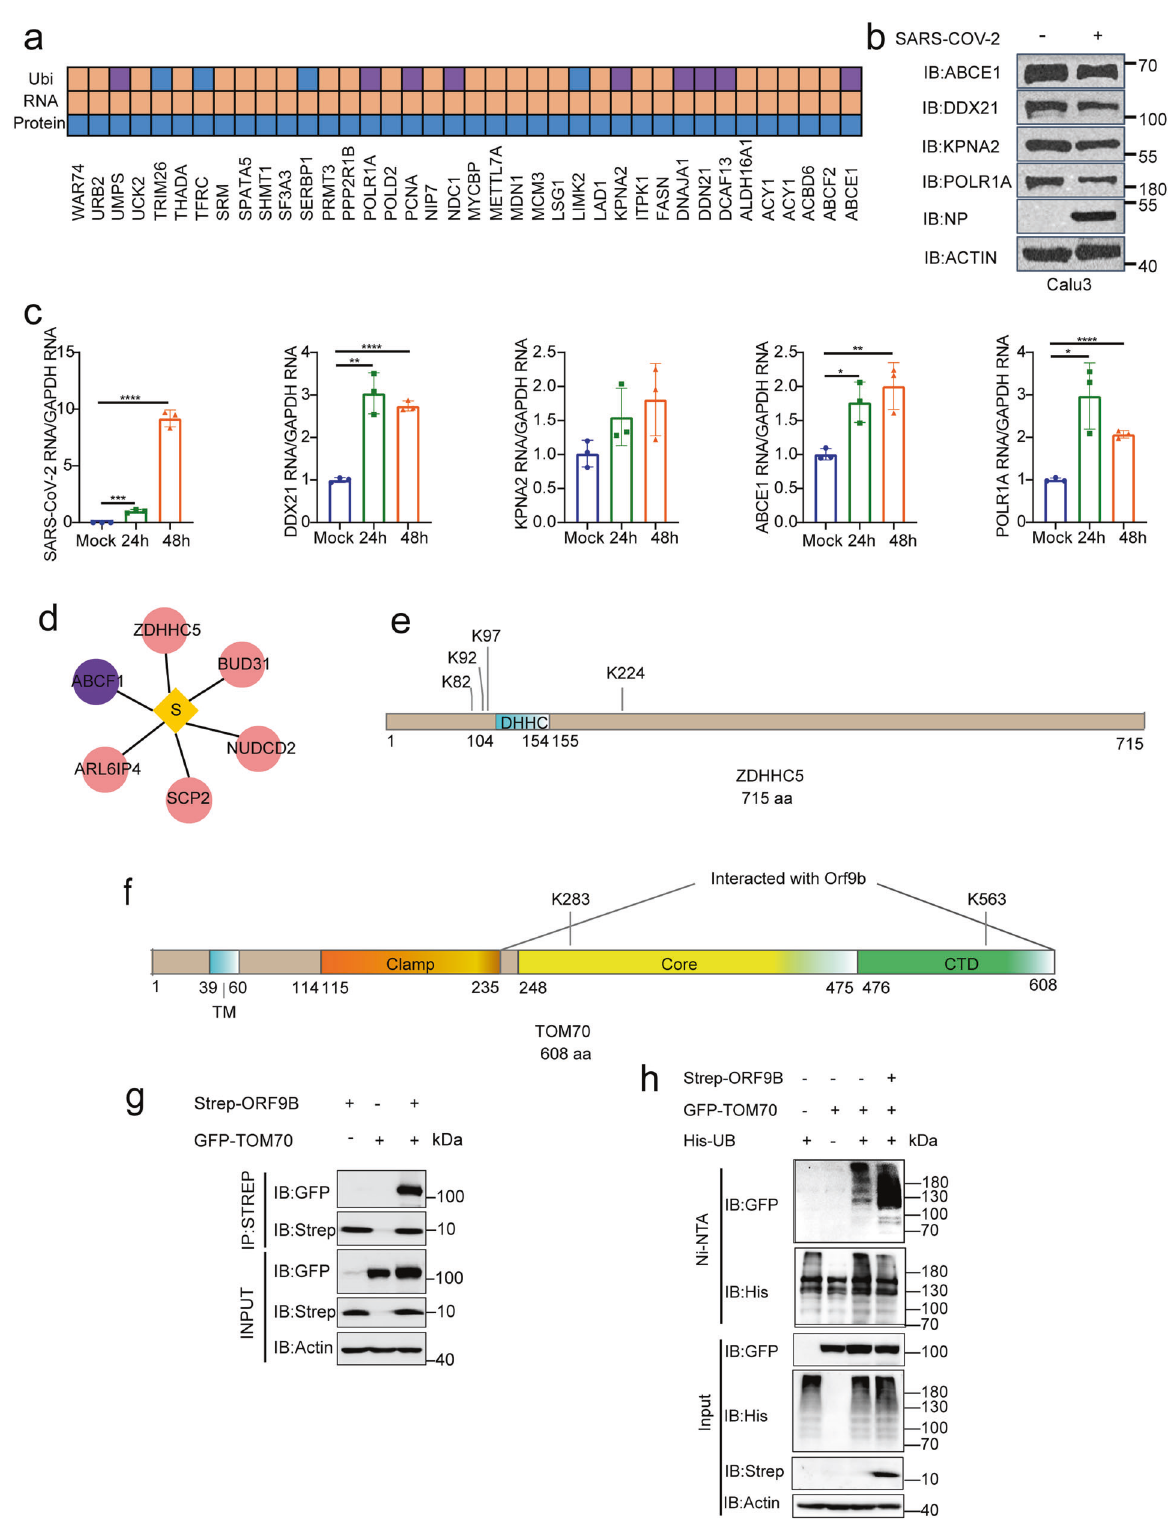
plasmid, and infected with SARS-CoV-2 at 0.3 MOI. Cells were collected 24 h after infection, the intracellular viral protein NP was detected using WB (Fig. 6a). After three replicates, twelve of E3 ligases and four of DUBs were shown to affect SARS-CoV-2 infection (Fig. 6b – d and Supplementary Fig. 6). The overexpression Signal Transduction and Targeted Therapy (2022)